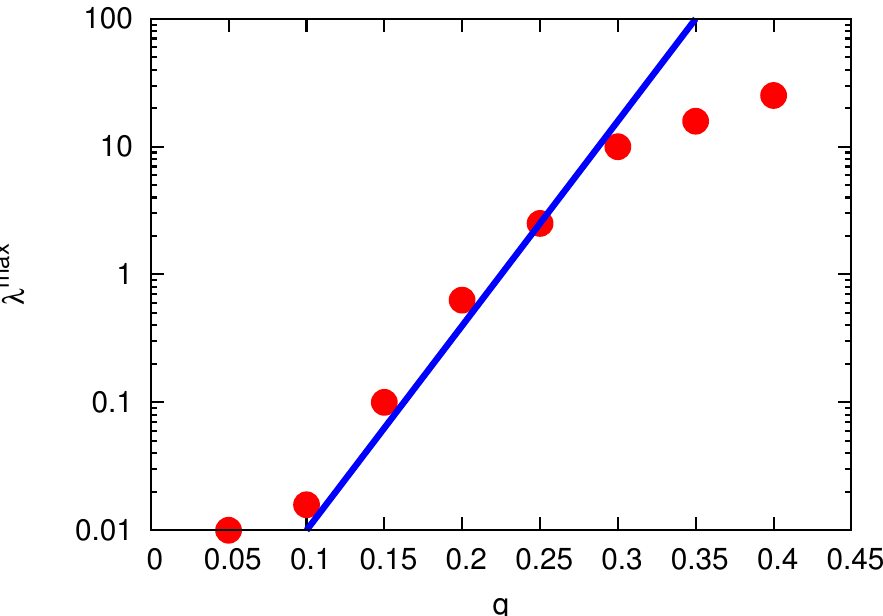
Figure 3. λ max as a function of q , illustrating how the loading rate, λ max , at which the number of the particles in the trap assumes its maximum, shifts toward higher loading rates as a function of increased q . Indicated by the straight blue line, representing the function λ max = 0.01 × 10 16 ( q − 0.1 ) , approximately exponential sensitivity is observed in the range 0.1 < q <